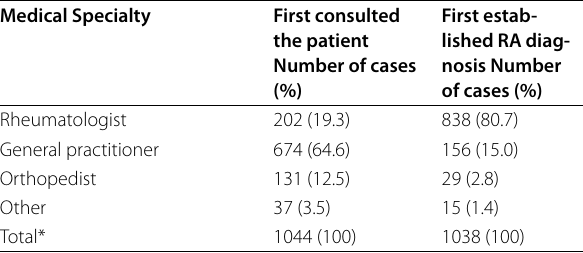
Table 2 Medical specialty who first consulted the patient and first established the diagnosis of RA,